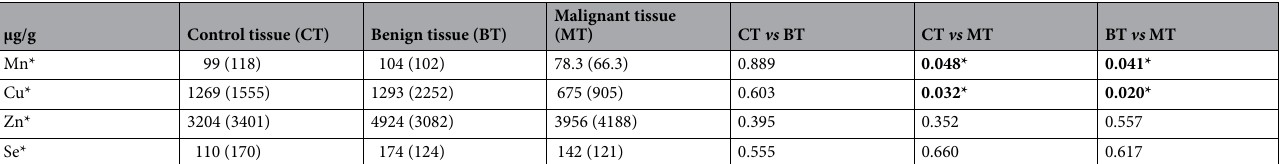
Table 3. Concentration of specific trace elements in control brain tissue (CT), benign tissue (BT) and malignant brain tissue (MT) expressed in (µg/g). The data are expressed as the median (interquartile range). Difference between groups was determined by nonparametric Mann–Whitney U test for independent groups with P < 0.05 as the level of significance. Differences between groups are marked as bold and with the asterisk